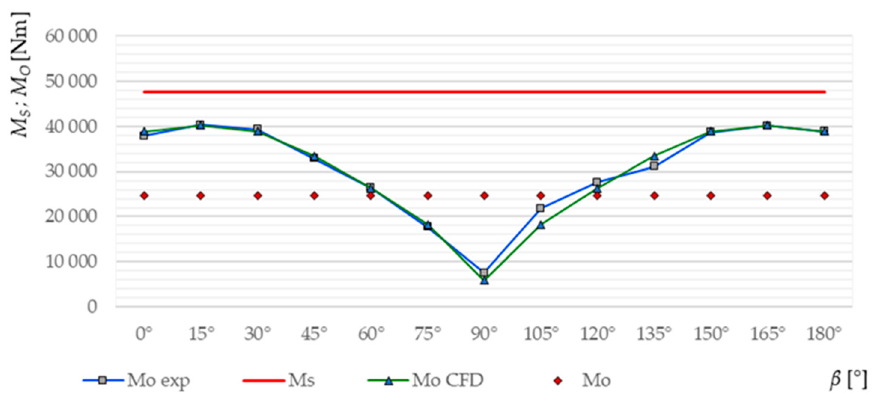
Figure 15. Comparison of the overturning and stabilizing moments received from the experimental and numerical tests with the calculation based on [17] for the wind speed V = 20 m/s (config. 1).